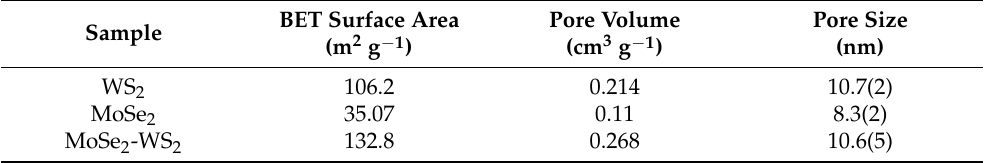
Table 1. BET analysis results of pristine WS 2 and MoSe 2 -WS 2 nanostructures.